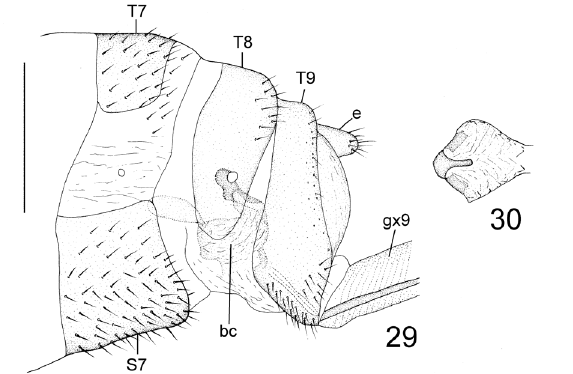
Figures 29–30. Dilar fuscus sp. n. 29. Female genitalia, lateral view; 30. Bursa copulatrix, ventral view. Scale bar = 0.5